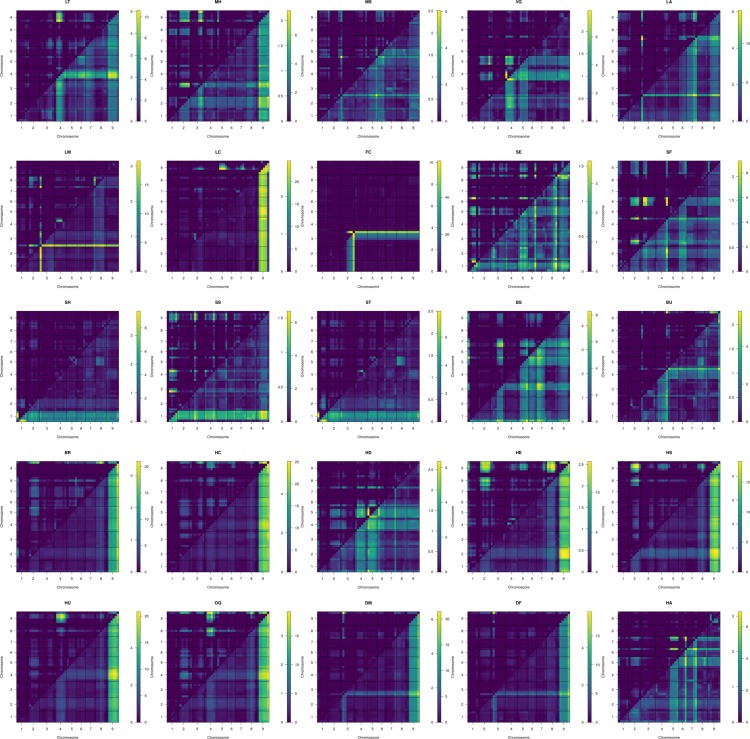
Two dimensional scans of all traits using 1,881 markers, using simulated genotype probabilities (N = 1000) with genotype probabilities calculated across 1 cm steps. Epistatic LOD scores are calculated the difference in the log-likelihood of the full model and the additive model for a given QTL pair and are printed above and left of trace. The full model LOD values are printed below and right of trace.